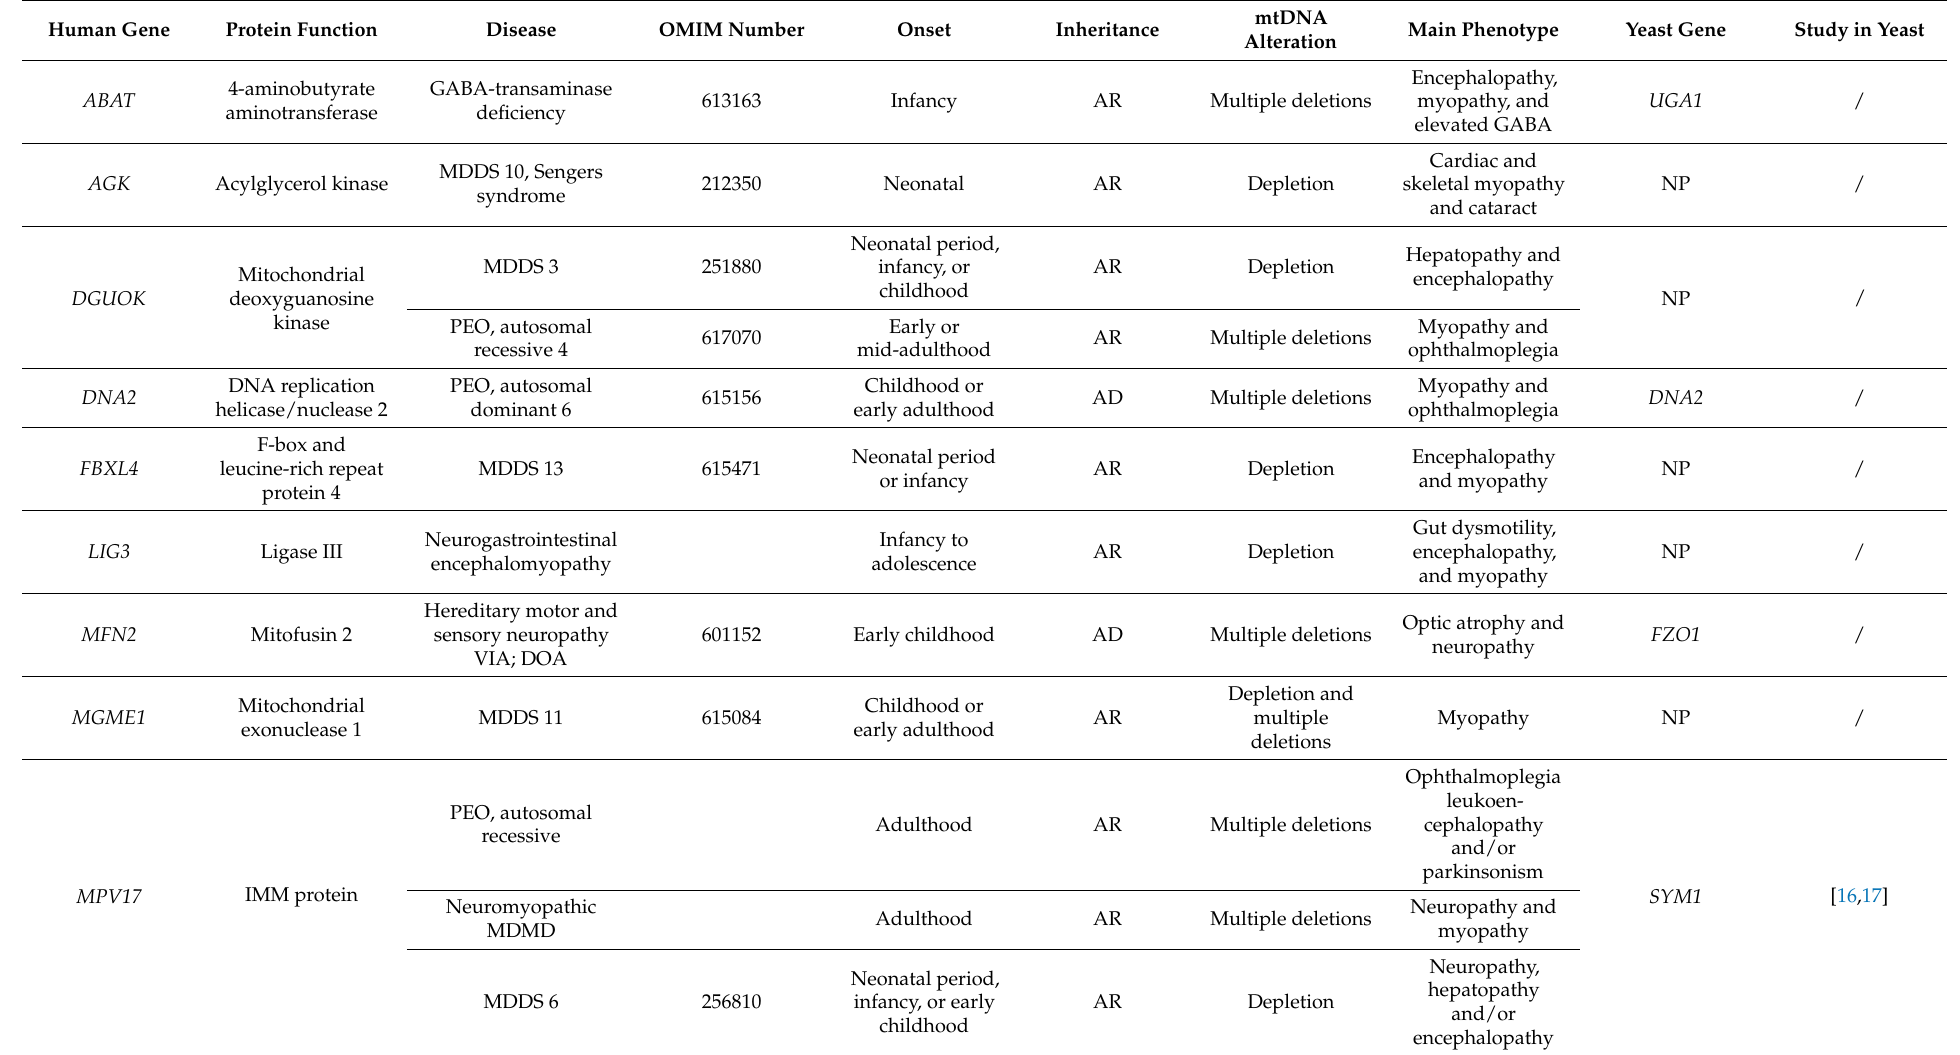
Table 1. Genes associated with mitochondrial diseases characterized by mtDNA depletion and/or multiple